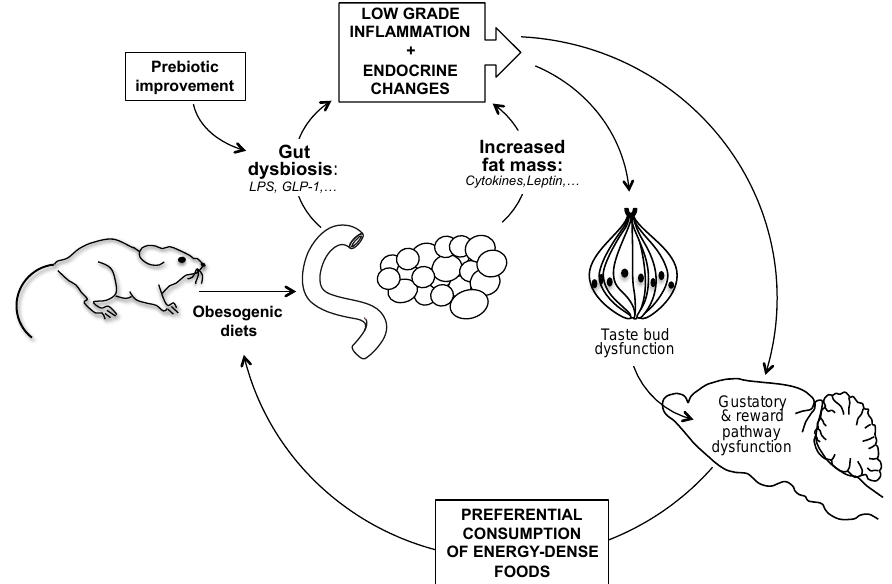
Figure 7. Functional relationships between diet-induced obesity and taste sensitivity in the mouse: Working model.